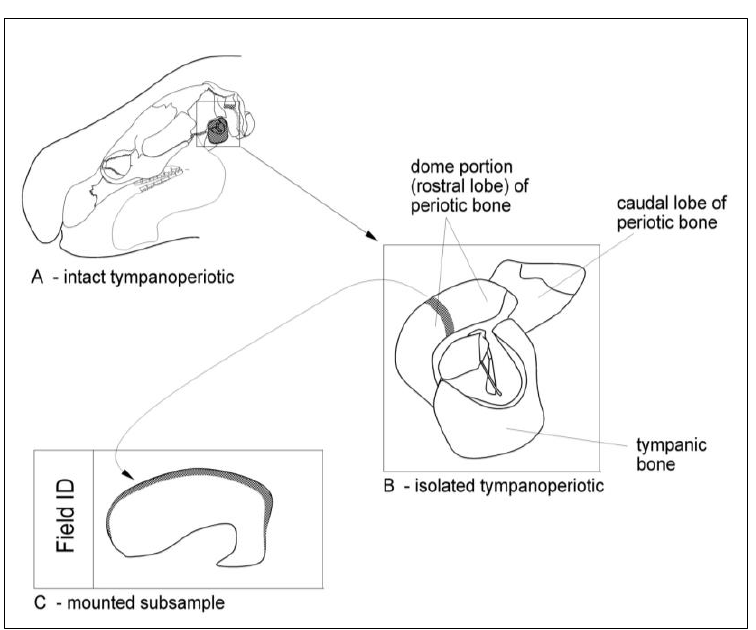
Fig. 1. Manatee earbone: A) the tympanoperiotic complex (earbone) intact in the skull, left lateral view; B) the isolated earbone with subsample region of dome portion highlighted; C) the earbone slide and the subsample region in the orientation used to read GLGs under the microscope. (pers. communication, Rommel